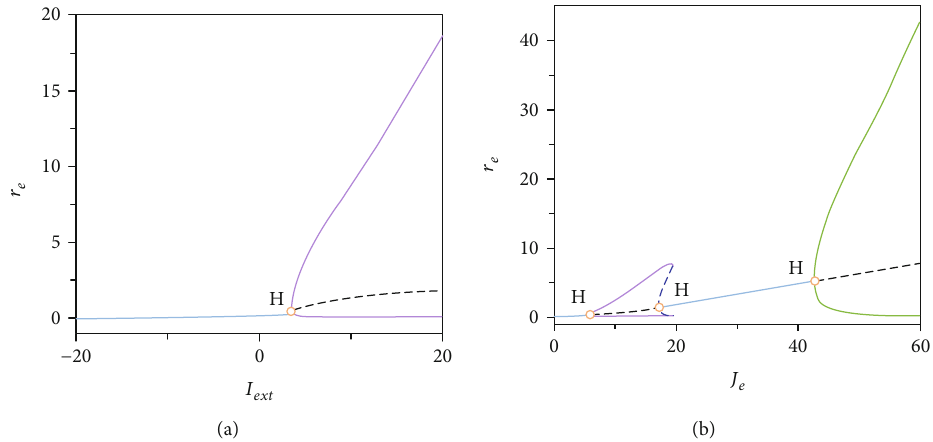
Figure 2: Two-parameter bifurcation diagram in the I , PD : period-doubling bifurcation curve (purple). PD 1 2